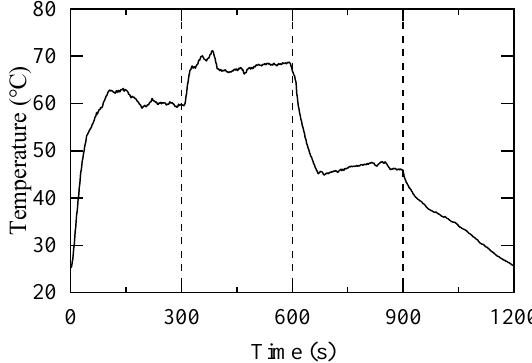
Figure 18. Temperature change over time.